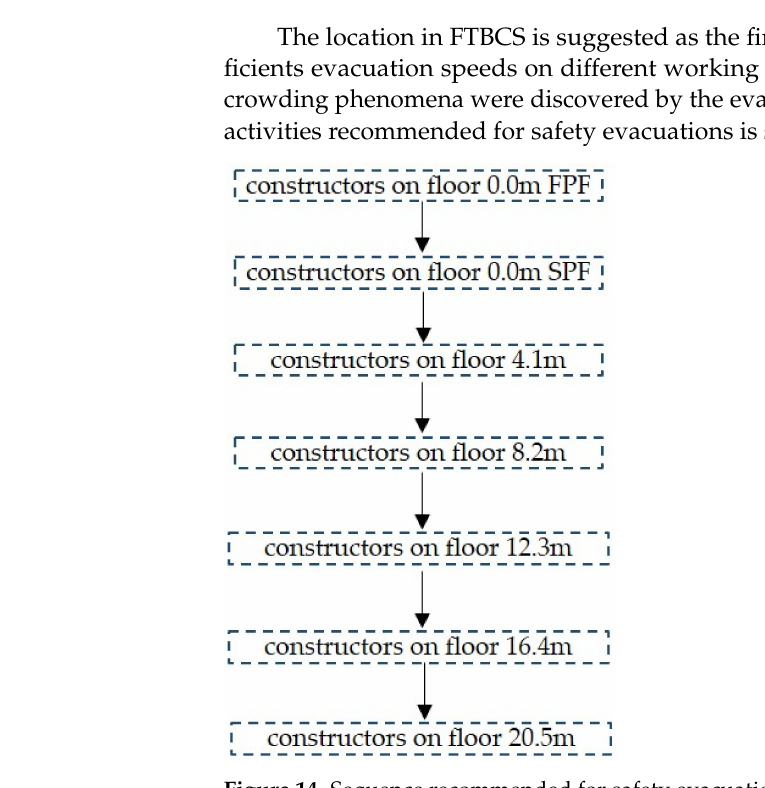
Figure 14. Sequence recommended for safety